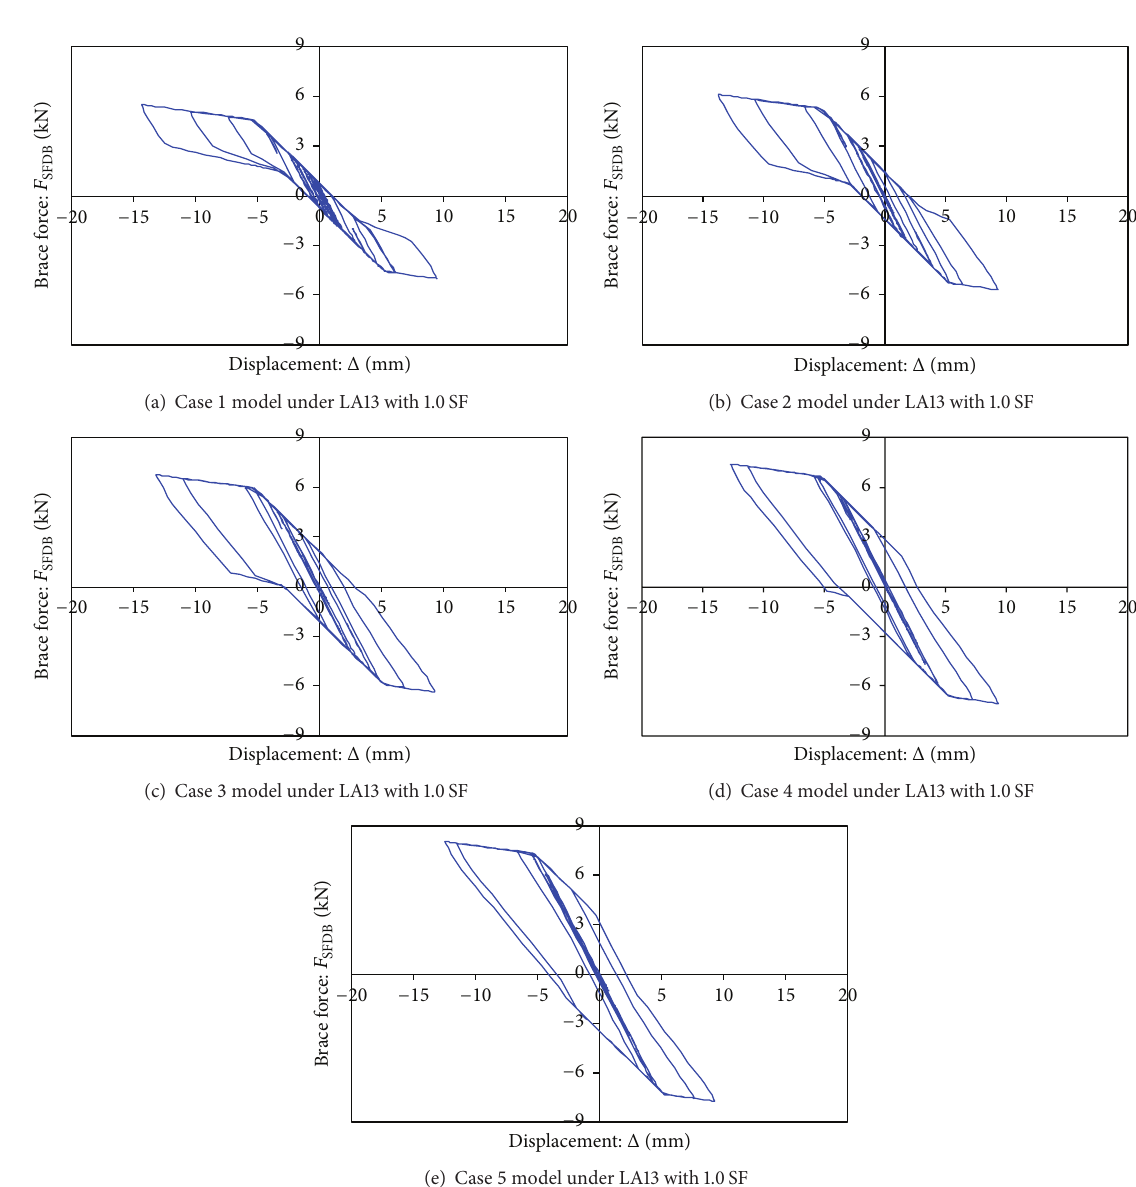
Figure 9: Force and displacement curves for individual SFDB models under the LA13 ground motion with 1.0SF.